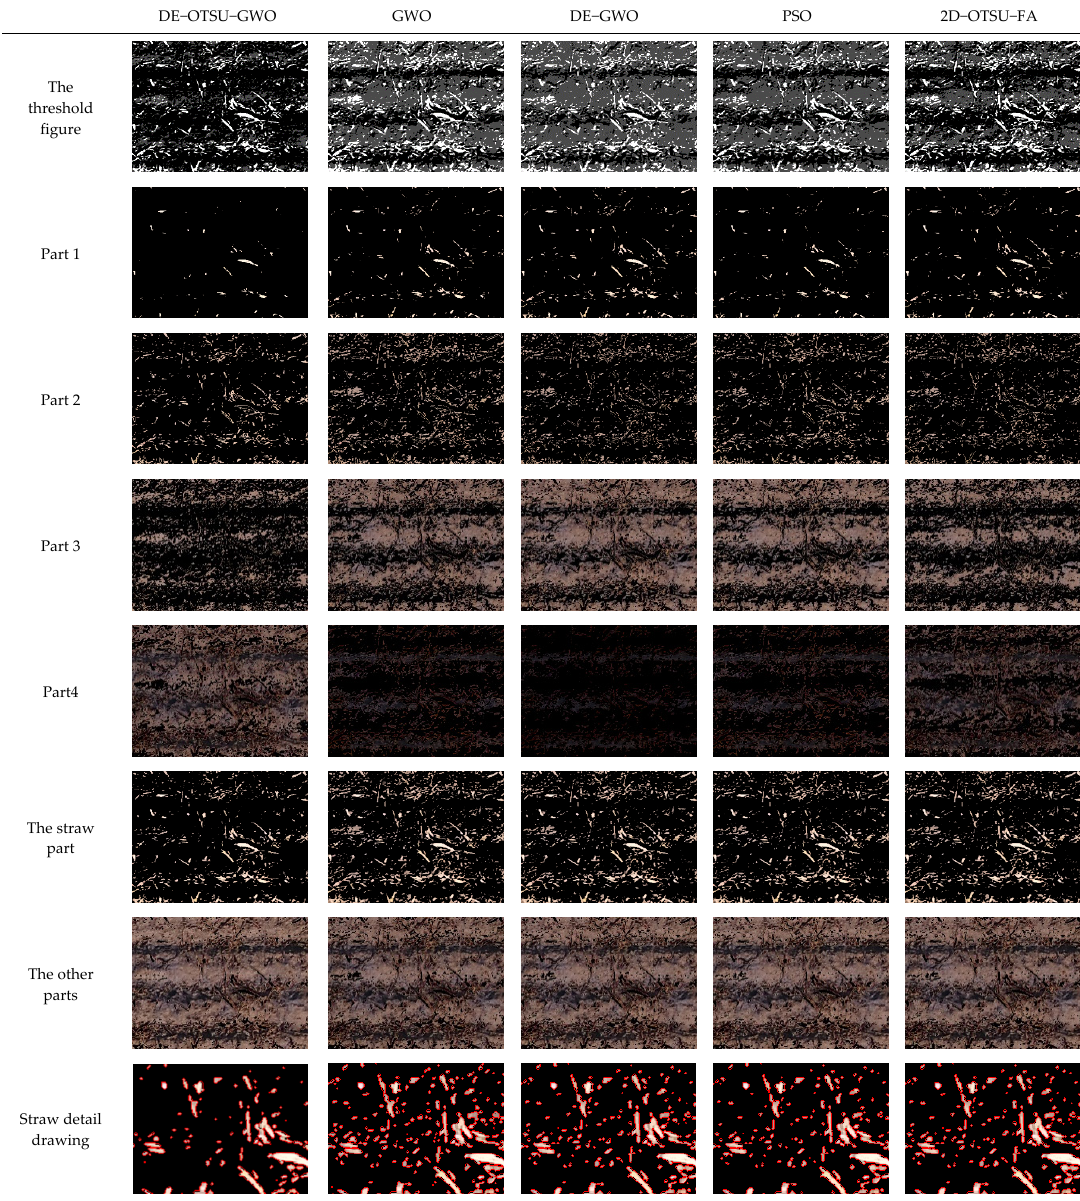
Figure 8. Image segmentation of five algorithms with the height of 30 m.